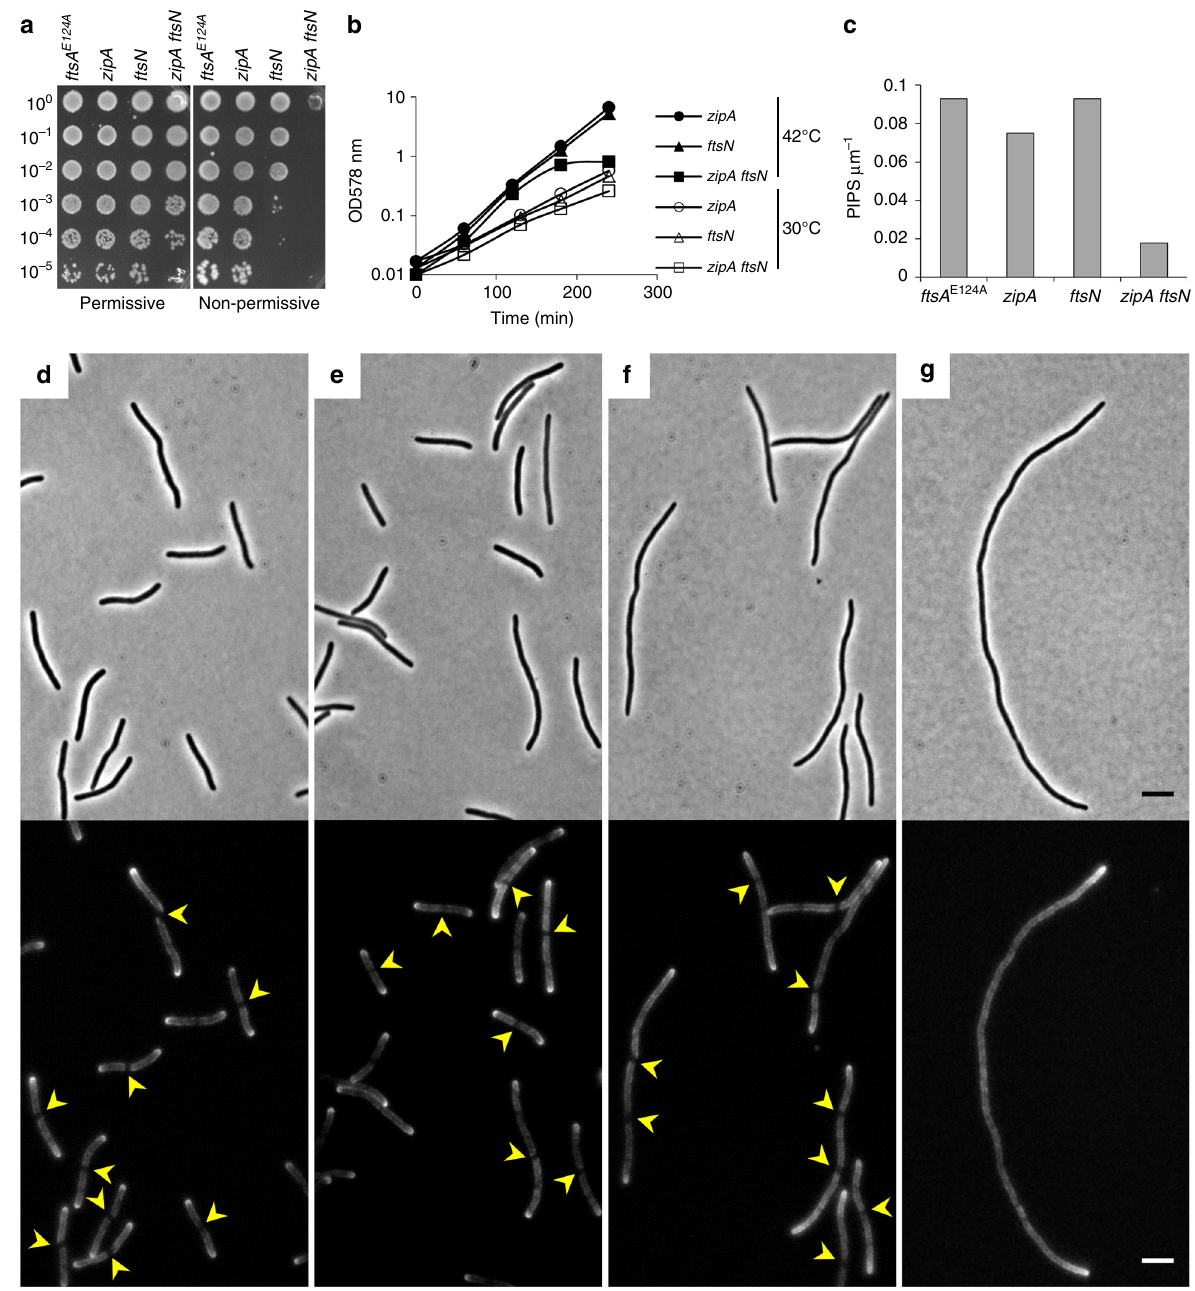
Fig. 5 FtsN and ZipA are required for preseptal peptidoglycan synthesis. a Ten-fold serial dilutions spotted plate of the parental strain WM2935 ( ftsA E124A ), MPW22 ( ftsA E124A Δ zipA / rep ts zipA ), MPW23 ( ftsA E124A Δ ftsN / rep ts ftsN ) and MPW29 ( ftsA E124A Δ zipA Δ ftsN // rep ts zipA ftsN ) strain cultures incubated at 30 °C (permissive) and 42 °C (non-permissive). b Representative growth curves of strains under permissive (open symbols) and non-permissive temperature (close symbols). Cell culture optical density (578 nm) was kept below 0.4 during the whole experiment. c Quanti fi cation of preseptal peptidoglycan synthesis (PIPS) bands per unit of cell length in the mentioned strains under non-permissive conditions (42 °C). d – g Phase contrast and HADA fl uorescent images for detection of preseptal PG synthesis in WM2935 ( d ), MPW22 ( e ), MPW23 ( f ) and MPW29 ( g ) cells under non-permissive conditions (42 °C). The non- fl uorescently labelled preseptal PG synthesis bands are indicated by yellow arrows. Scale bars represent 5 µ promote FtsA monomerization 34 . The ftsA* allele increases the division has been proposed to occur when the direct interaction number of FtsA* monomers and, hence, the number of FtsA*- between MreB and FtsZ is impaired, causing cell fi lamentation FtsN complexes available for interactions with the PBPs, ren- and loss of viability 26 . Although mature cell division rings (containing PBP3 and FtsN among other proteins) were located dering ZipA dispensable. If zipA is absent, FtsN becomes the only at the division sites, in this case there was no preseptal or septal linker between the cytosolic proto-ring (formed by FtsA* and PG synthesis, suggesting a defective transfer of the PG synthesis FtsZ) and the bifunctional PG synthases, explaining the lack of machinery from the elongasome and the divisome 26 . Although viability of the ftsA* cells in the absence of both, ZipA and FtsN. other cell division proteins (FtsK, FtsQ, FtsEX, PBP3) are A similar defect in the transition from cell elongation to cell